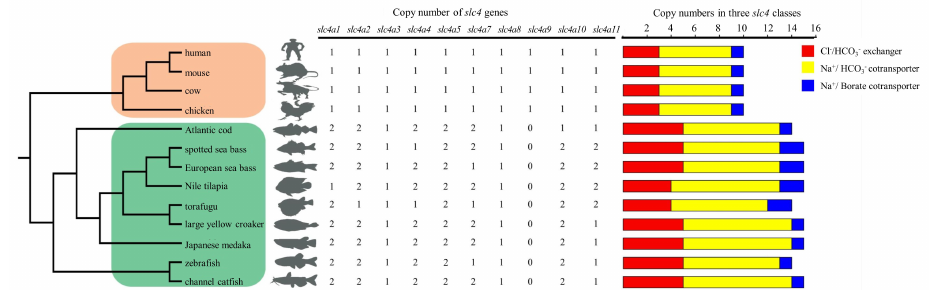
Figure 5. Copy numbers of slc4 genes in 13 representative vertebrates. Branch shades represent the di ff erent groups: higher vertebrates were marked by orange shade and teleosts were shown in green. The copy number of three slc4 classes were represented by colored rectangle: Cl − /HCO 3 − exchangers in red, Na + /HCO 3 − transporters in yellow and Na + /Borate transporters in blue.